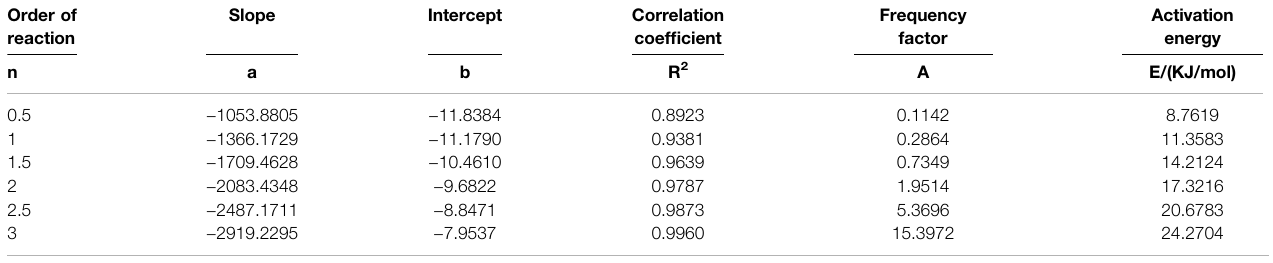
TABLE 3 | Calculation results of the sludge cracking mechanism model.